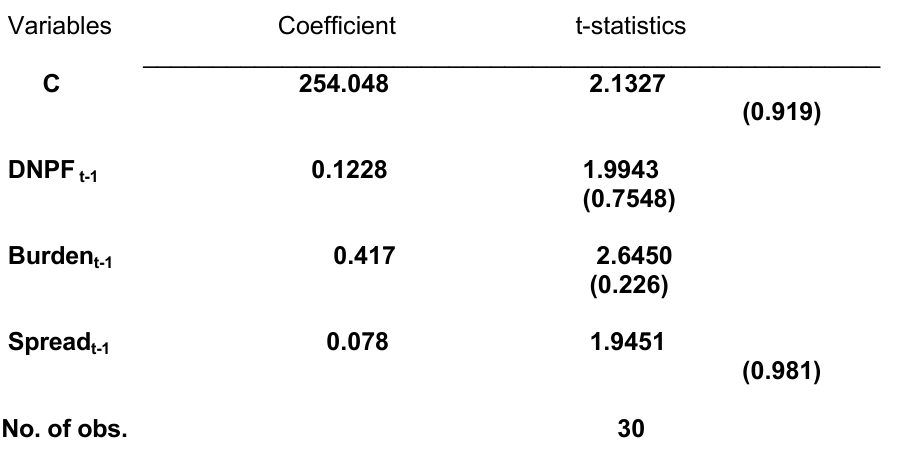
Table-04: Intermediation Cost and Non-Performing Financings